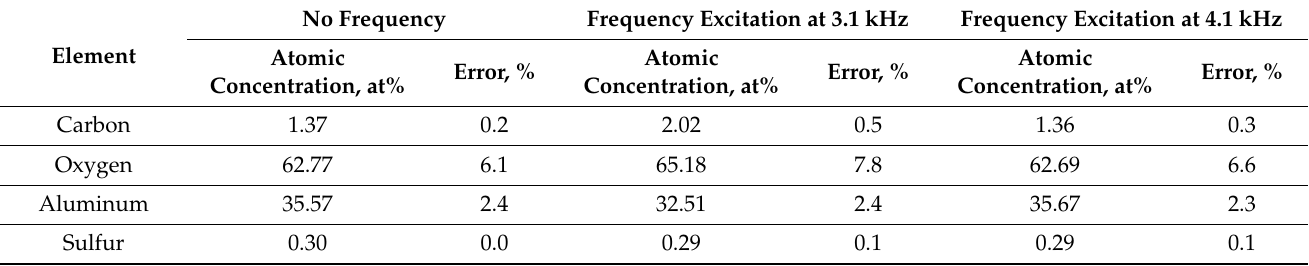
Table 4. Chemical composition of AAO nanoporous